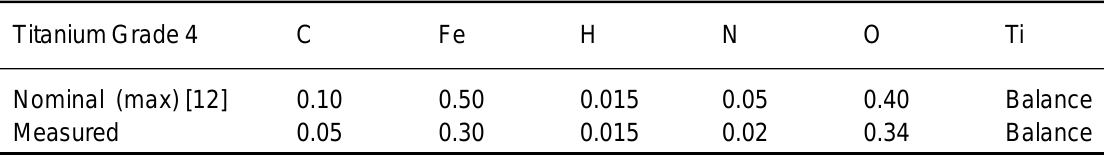
Table 1. Chemical composition (wt.%) of titanium Grade 4.